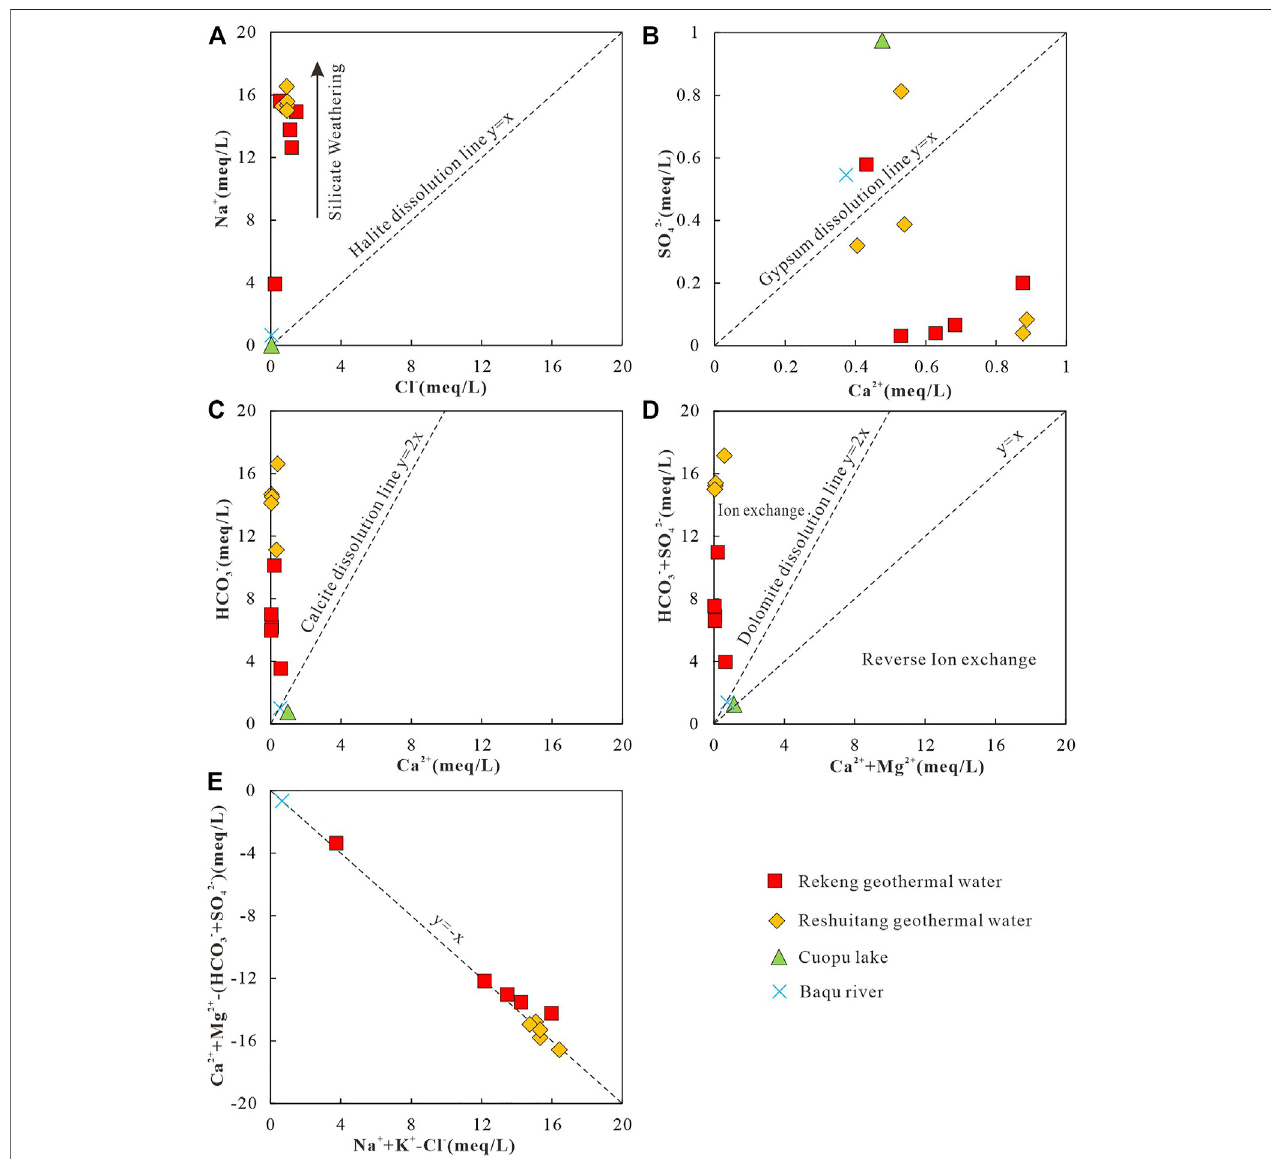
FIGURE 6| Diagram ofthe determination of hydrochemical processes based on the molar ratio among the main ions in water. (A) Cl- vs. Na+, (B) Ca 2+ vs. SO 42 − , (C) Ca 2+ vs. HCO 3 − , (D) (Ca 2+ +Mg 2+ ) vs. (HCO 3 − + SO 42 − ), and (E) (Na + +K + )-Cl − vs. (Ca 2+ +Mg 2+ )-(SO 42 − + HCO 3 −